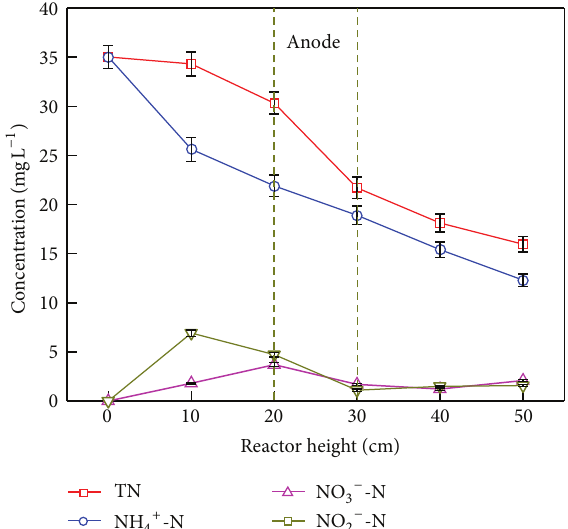
Figure 7: The change of different forms of nitrogen in the unplanted